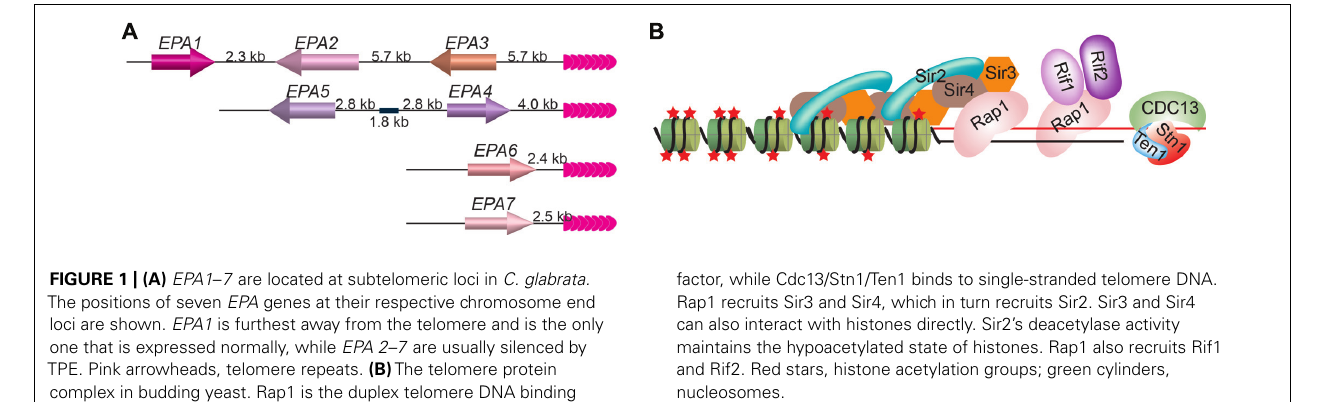
FIGURE 1 | (A) EPA1 – 7 are located at subtelomeric loci in C. glabrata. The positions of seven EPA genes at their respective chromosome end loci are shown. EPA1 is furthest away from the telomere and is the only one that is expressed normally, while EPA 2–7 are usually silenced by TPE. Pink arrowheads, telomere repeats. (B) The telomere protein complex in budding yeast. Rap1 is the duplex telomere DNA binding